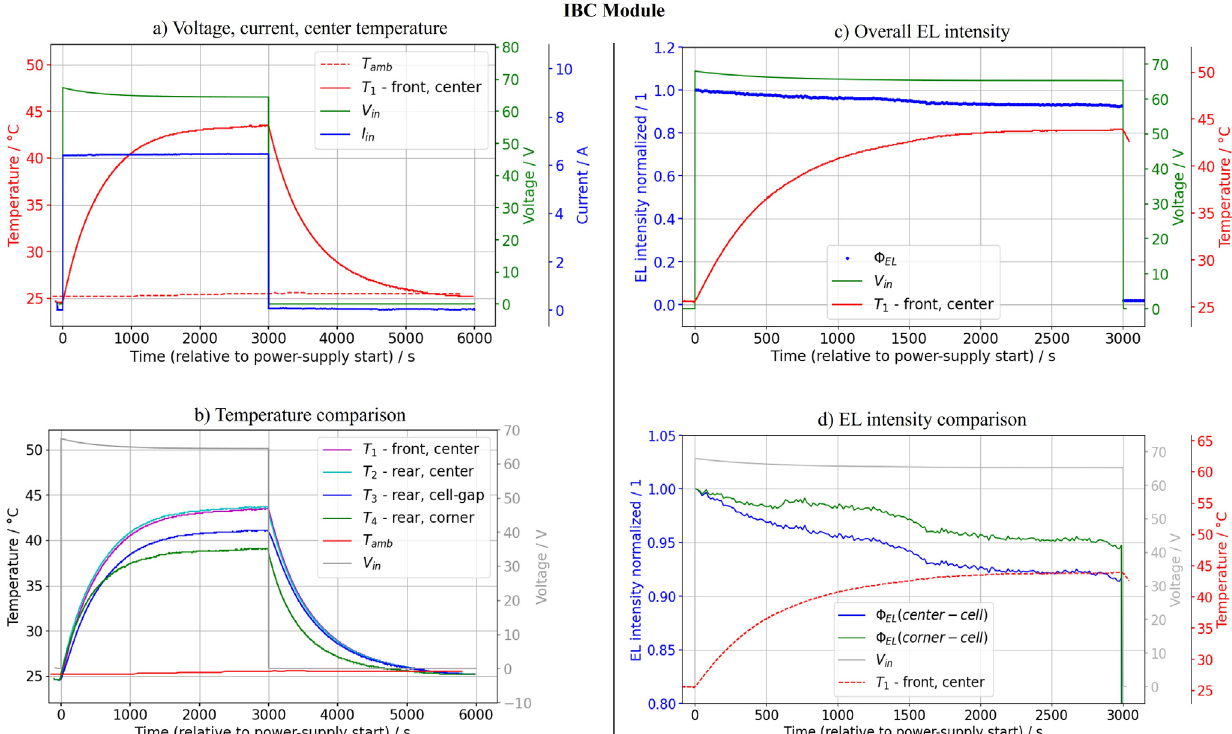
Fig. B.2. Experimental results of IBC module. Voltage, current and centered cell temperature (a), comparison of all temperatures measured (b), evolution of the electroluminescence signal over measurement time (c) and comparison of two electroluminescence signals measured for a center and a corner cell of one module